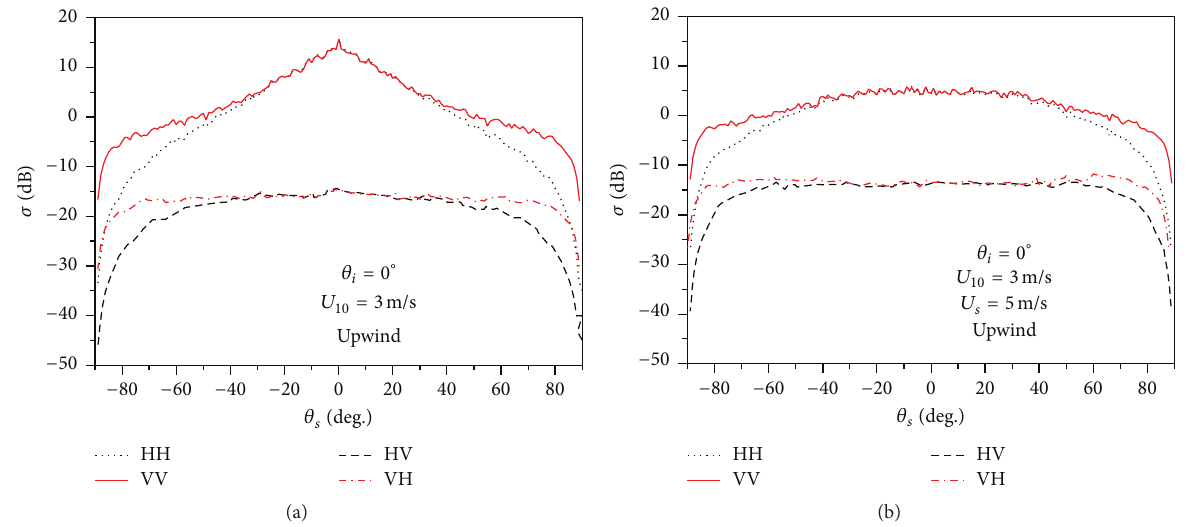
Figure 12: Bistatic polarimetric scattering coefficient versus scattering angle 𝜃 𝑠 with wind speed 𝑈 10 = 3 m/s for incident angle 𝜃 𝑖 = 0 ∘ . (a) Sea alone and (b) sea with wake.